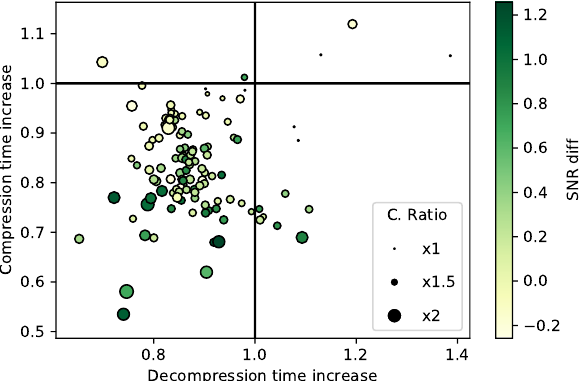
Figure 10. Results of executing PCA + JPEG2000 and Jypec over our test images with parameters from configurations F j , j = 0, . . . ,19. Shave bits and clusters were only applied for Jypec. Black lines indicate separation between faster decompression (left of vertical line) and faster compression (below horizontal line). Execution times clearly decrease for both compression and decompression. Compression ratio also improves consistently, being always better and almost double in some cases. SNR mostly improves, and where it does not, the increase in compression ratio makes up for it (see Figure